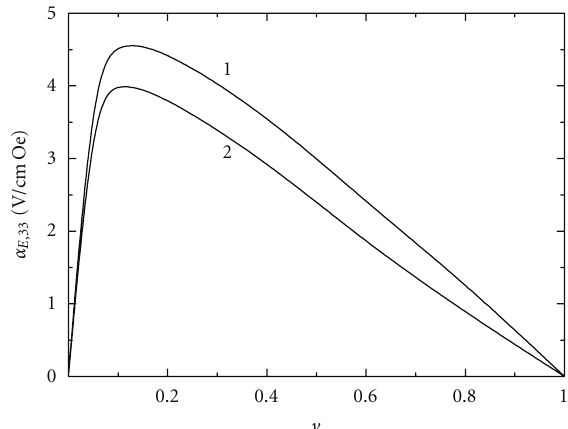
Figure 8: PZT volume fraction dependence of ME susceptibility for CFO-PZT composite with connectivity 3-0.